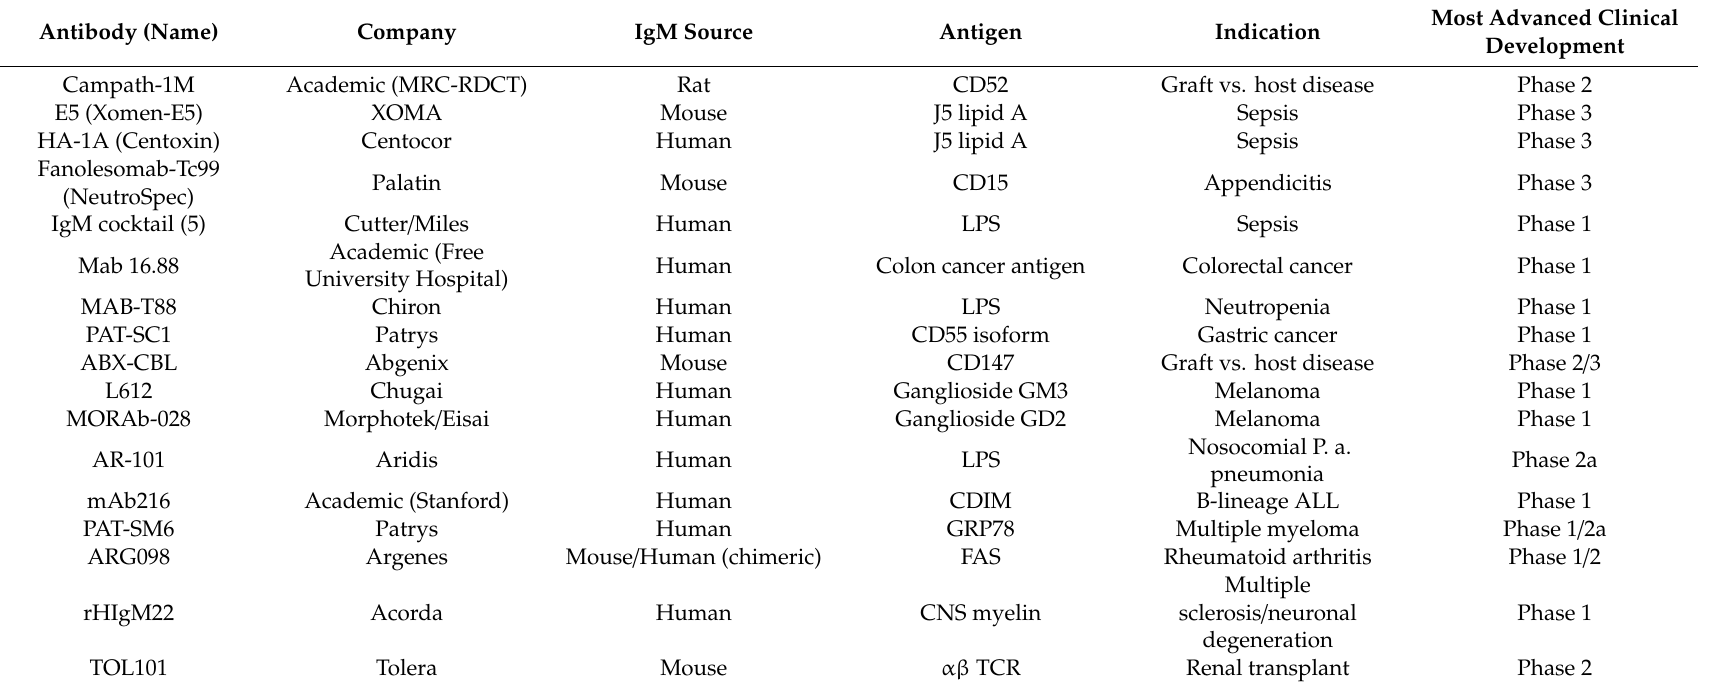
Table 2. Overview of IgM antibodies tested in human clinical